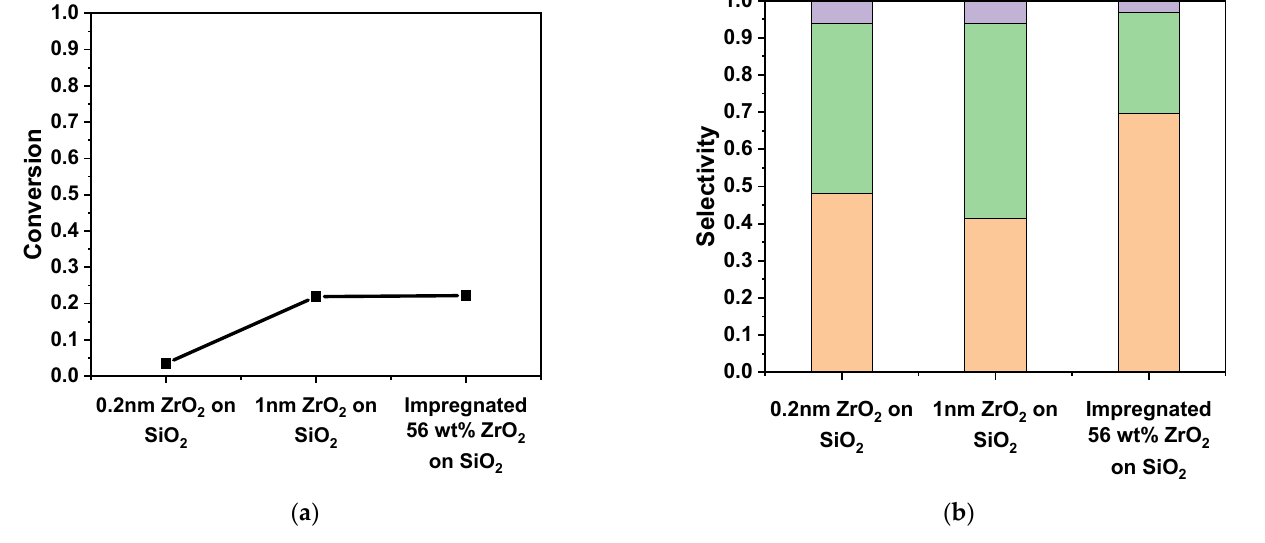
Figure 9. ( a ) THF conversion at 673 K on 0.2 nm, 1 nm, and impregnated 56 wt% ZrO 2 -SiO 2 samples (WHSV = 1.86 g THF/g cat/h). ( b ) The corresponding product selectivities: orange-butadiene; green- propene; purple-butene.